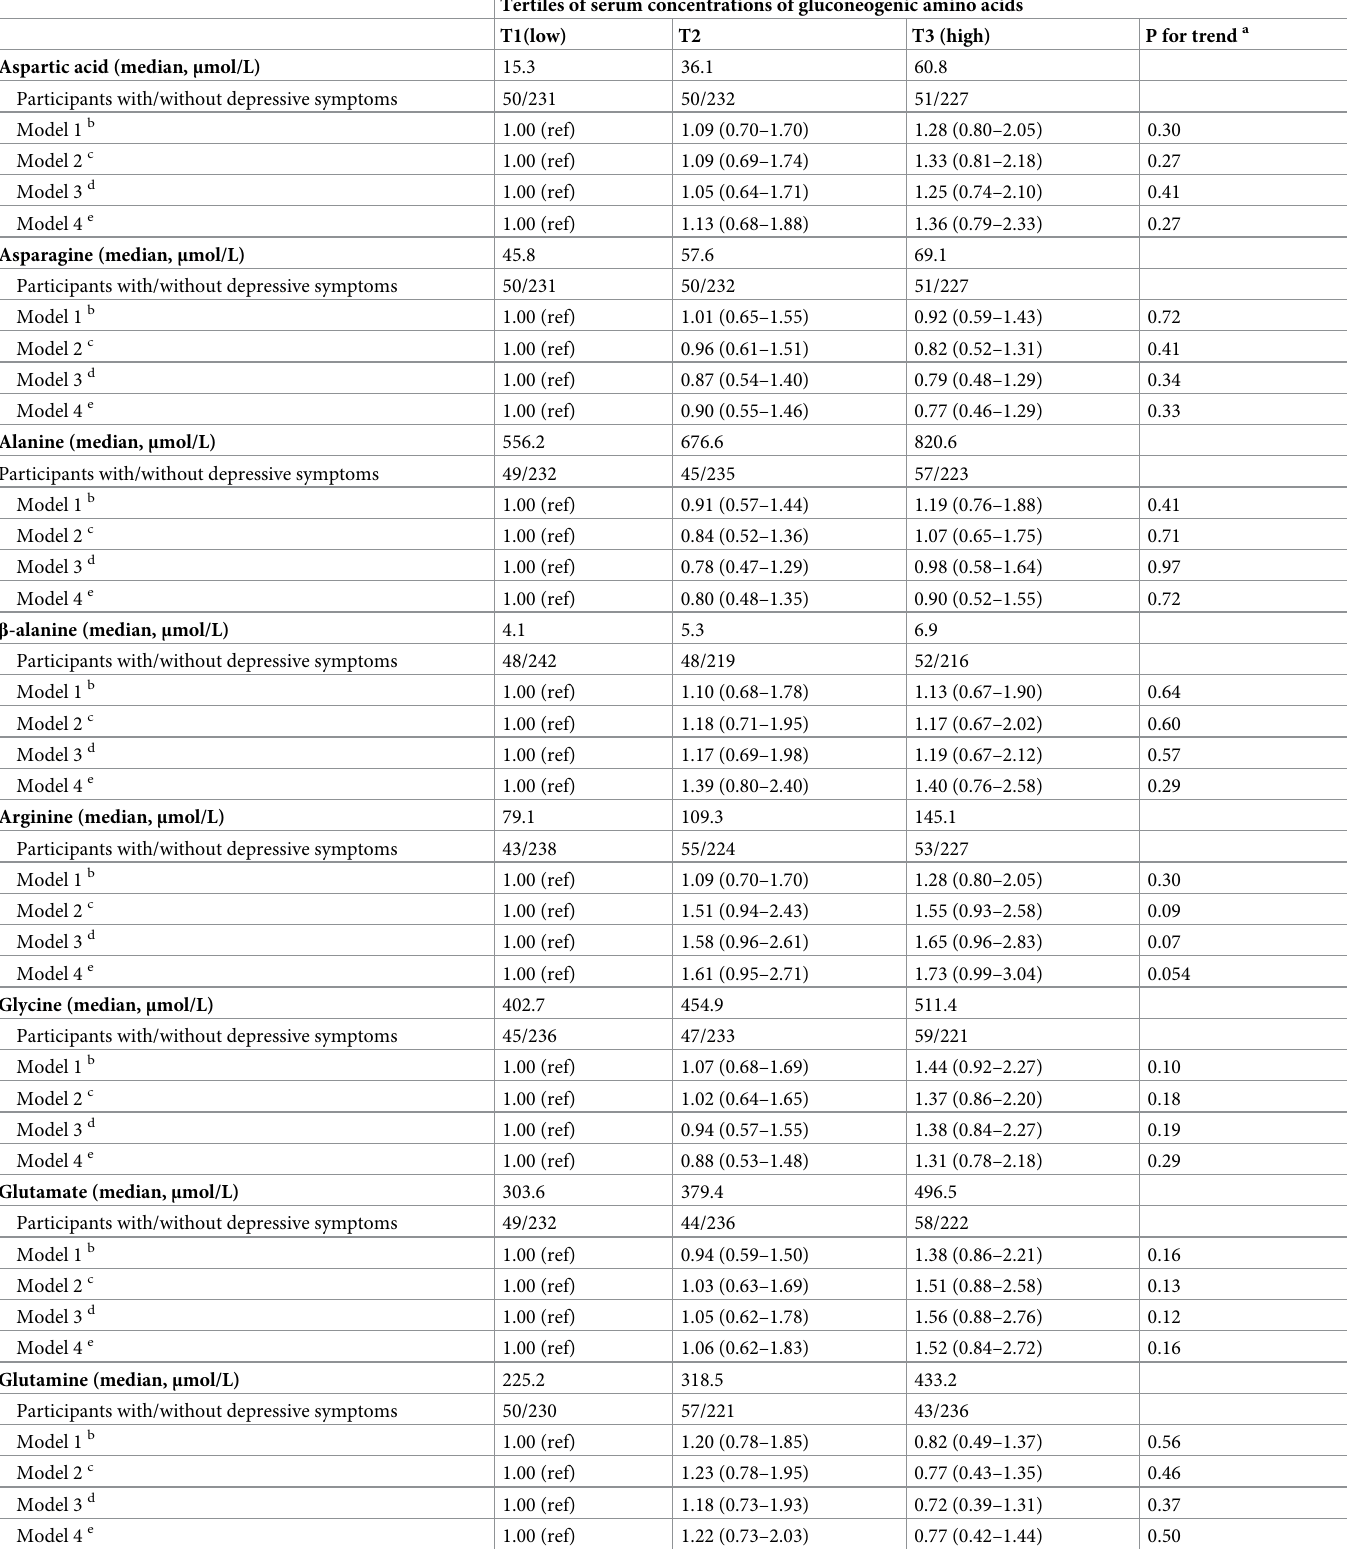
Table 2. Associations of serum concentrations of gluconeogenic amino acids with depressive symptoms.